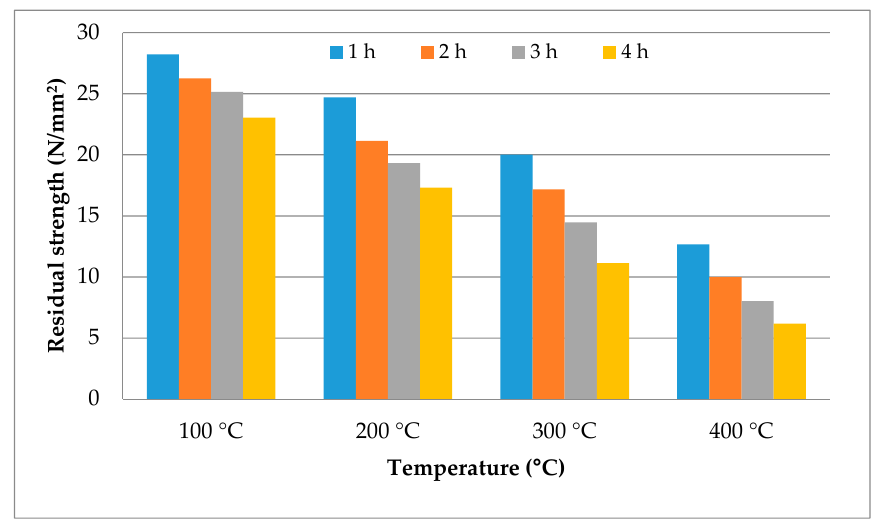
Figure 10. Temperature versus residual strength of CSC mix.